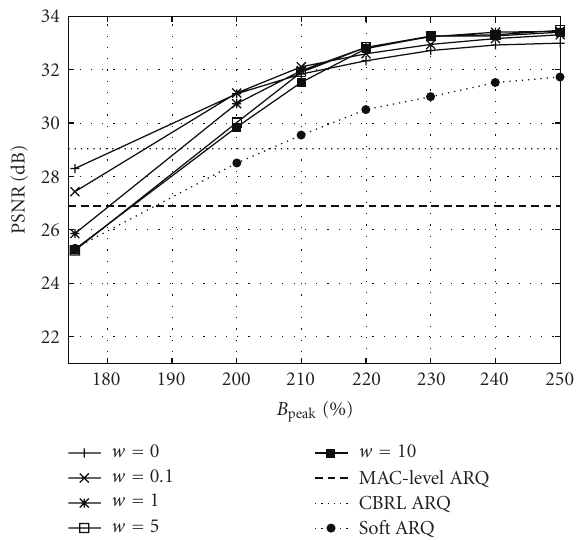
Figure 11: PSNR as a function of the peak bandwidth for the pro- posed ARQ scheme for di ff erent values of the w parameter, com- pared to the Soft ARQ technique and to the best performance of the MAC-level and CBRL ARQ schemes ( tempete sequence.) Transmis- sion through the relay